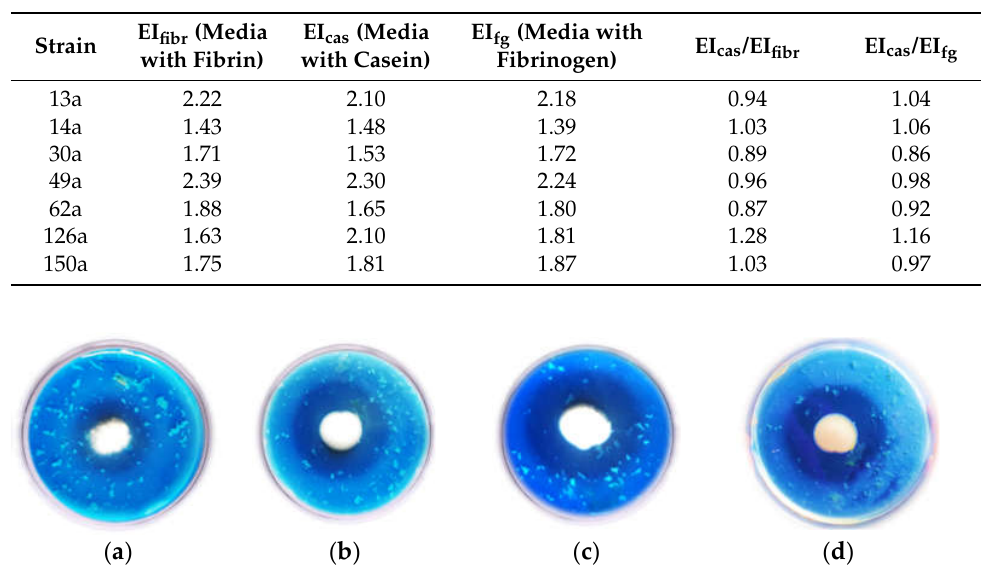
Table 2. Enzymatic index determination of Tolypocladium strains in media with different substrates.